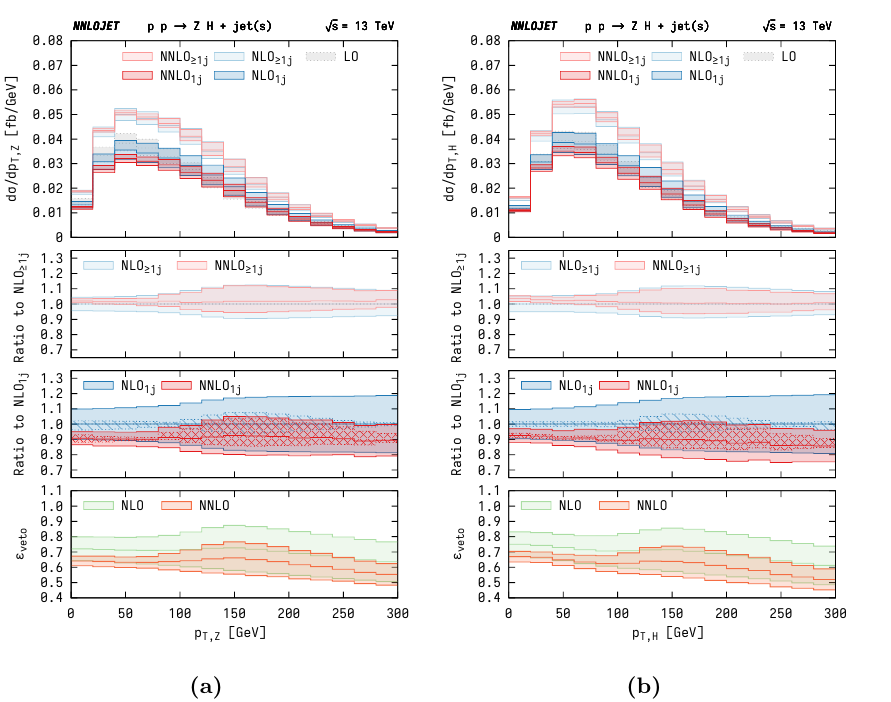
Figure 3. Transverse momentum distribution of (a) the gauge boson and (b) the Higgs boson for the ZH + jet